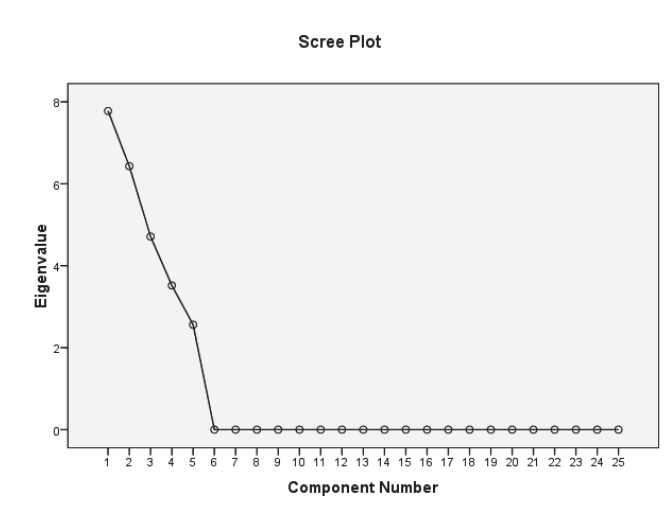
Fig. 4. The plot of